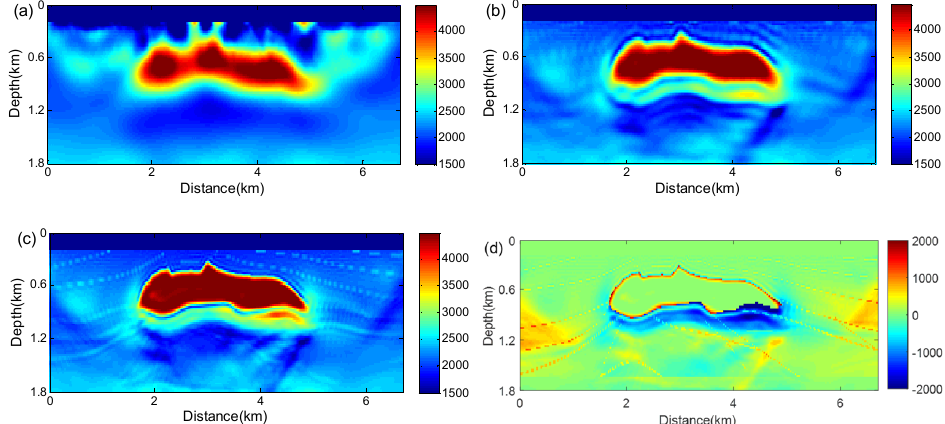
Figure 7. Inversion results by WDDEI and FWI. ( a ) WDDEI result. ( b ) WDDEI + FWI result with data frequency band of 4–8 Hz. ( c ) WDDEI + FWI (4–8Hz) + FWI(4–18Hz) result. ( d ) Difference profile between Figures 4a and 7c.